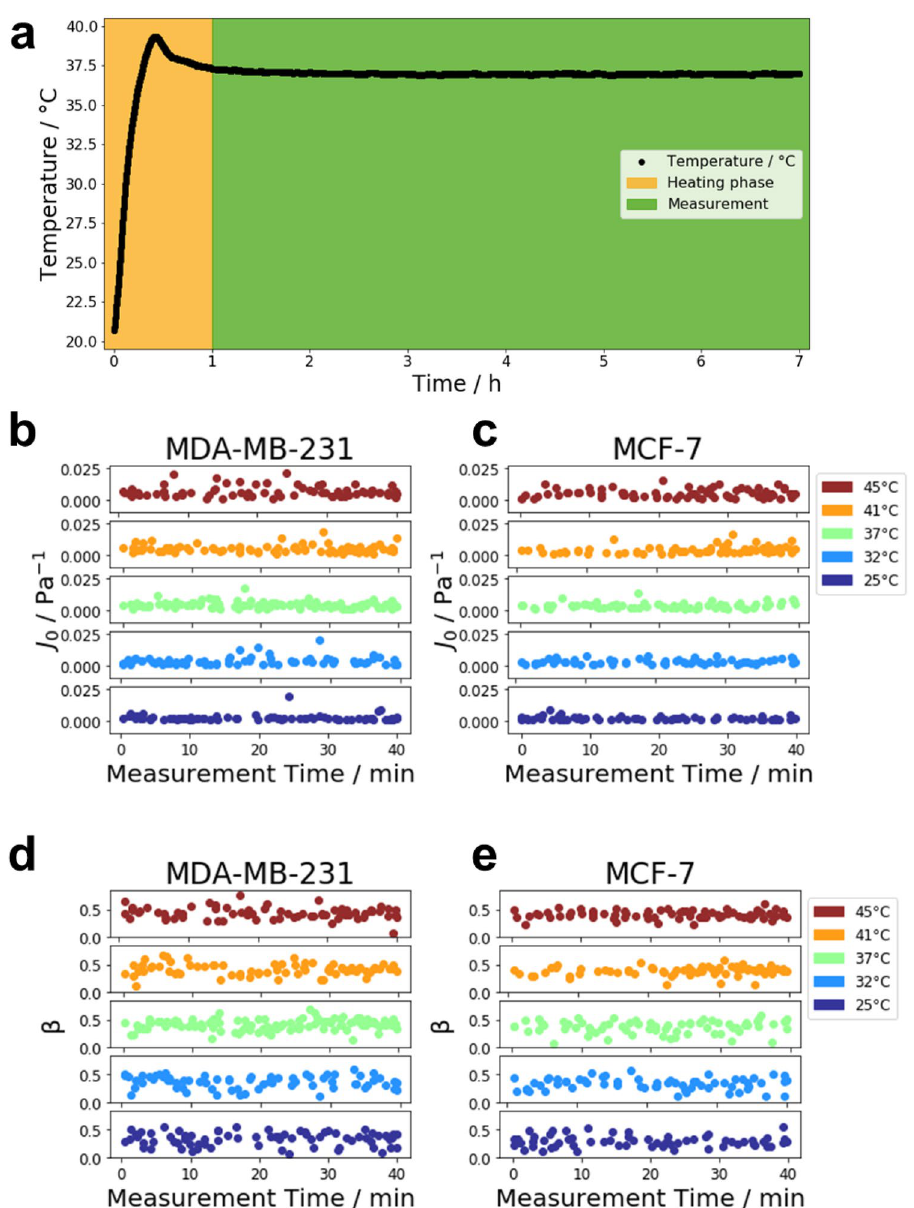
Figure 1. Heat stability of the magnetic tweezer system. (a) Heating curve measured inside the incubation chamber with a target temperature of 37 °C. Temperature was recorded over the duration of a typical measurement. The recording starts at the time the heating unit is switched on. The heating phase is displayed in orange and lasts for about 1 h. During the heating, the temperature inside the chamber rises drastically to a temperature slightly above the target temperature. After that, the temperature drops down to the target temperature and remains stable during the time of measurement (displayed in green). During the magnetic tweezer measurement the J 0 value of MDA-MB-231 (b) and MCF-7 (c) breast cancer cells was not significantly altered over time and also the β value of MDA-MB-231 (d) and MCF-7 (e) cells was not significantly changed over time. This has been shown for all chosen temperatures, such as 25 °C, 32 °C, 37 °C, 41 °C and 45 °